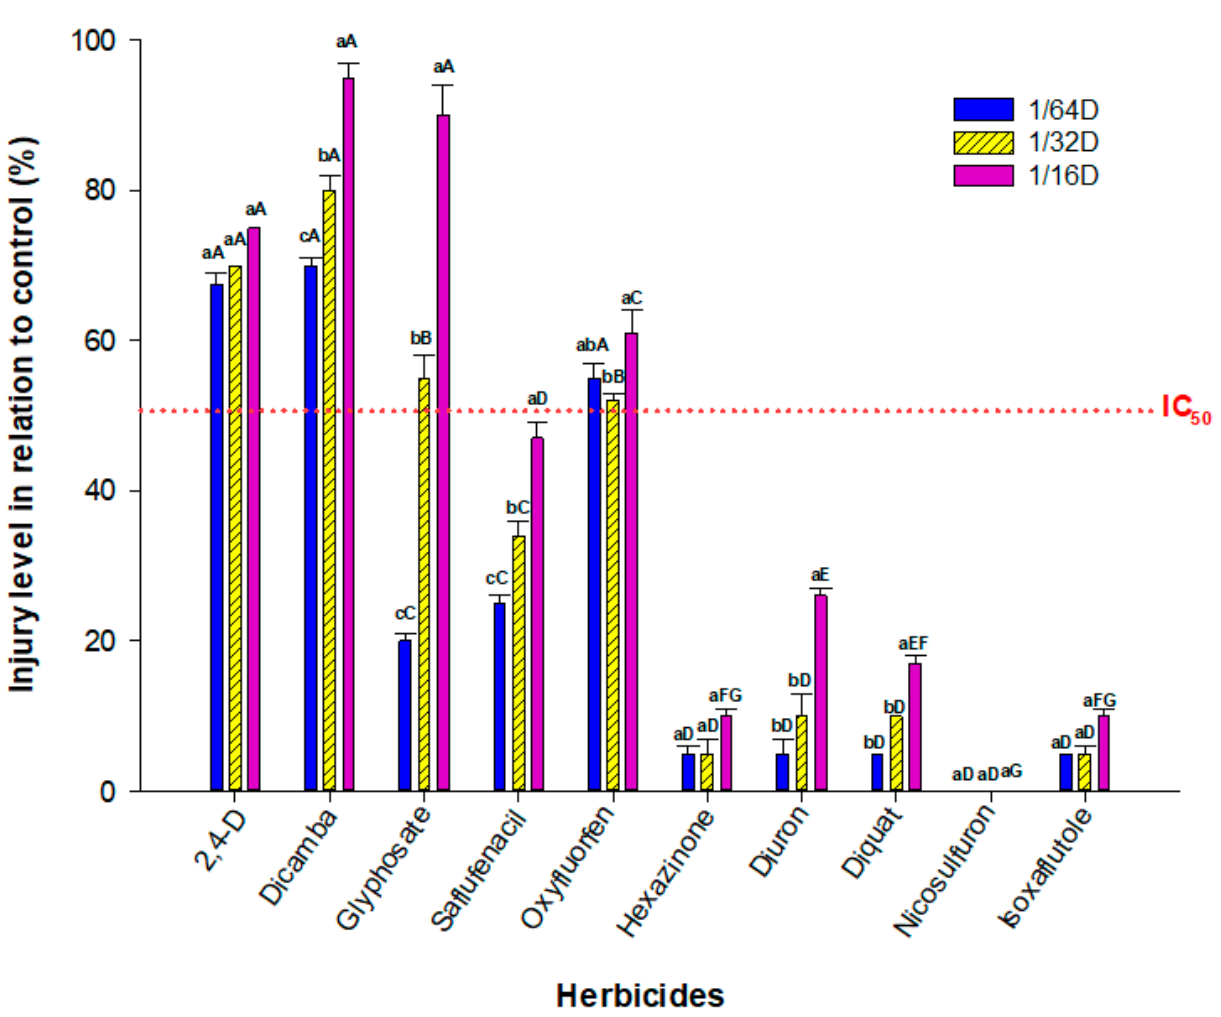
Figure 20. Injury level at 21 days after application (DAA) in relation to the control treatment, under different herbicides subdoses in the simulated drift of 2,4-D (146.56, 73.28, and 36.64 g a.e. ha − 1 ), dicamba (45, 22.5, and 11.25 g a.e. ha − 1 ), glyphosate (138.75, 69.38, and 34.69 g a.e. ha − 1 ), saflufenacil (8.75, 4.38, and 2.19 g a.i. ha − 1 ), oxyfluorfen (90, 45, and 22.5 g a.i. ha − 1 ), hexazinone (24.75, 12.38, and 6.19 g a.i. ha − 1 ), diuron (200, 100, and 50 g a.i. ha − 1 ), diquat (43.75, 21.88, and 10.94 g a.i. ha − 1 ), nicosulfuron (3.75, 1.88, and 0.94 g a.i. ha − 1 ) and isoxaflutole (16.41, 8.20, and 4.10 g a.i. ha − 1 ). The subdoses correspond to the proportion of 1/16D, 1/32D, and 1/64D of the commercial dose, respectively. The simulated drift doses with equal lowercase letters between herbicides and equal uppercase letters between the simulated drift dose proportions do not differ among themselves by Tukey’s test ( p < 0.05). The IC 50 represents the dose that causes 50% injury. At 21 DAA, there was no difference in injury level with increasing dose ratios in simulated 2,4-D drift, indicating a consistent injury level of approximately 70% regardless of subdose (Figure 20). However, with the dicamba herbicide, the injury level increased as the dose proportions applied increased, reaching approximately 95% control in the